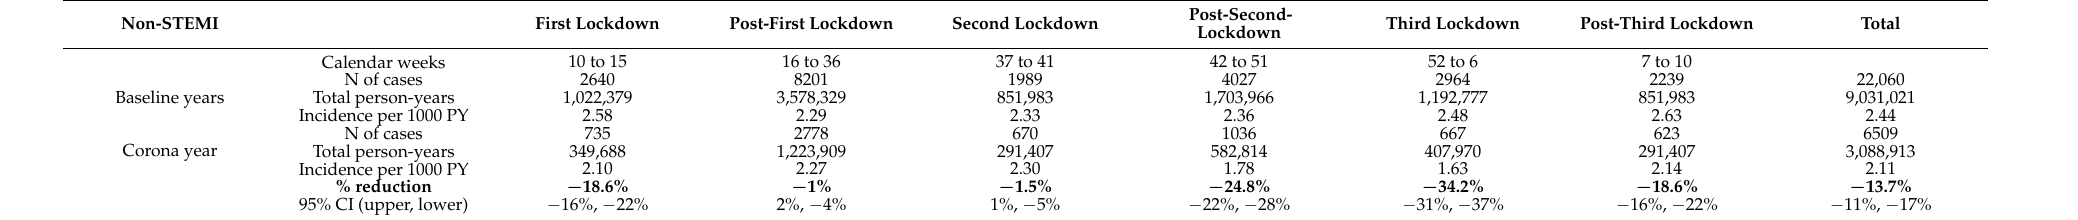
Table 3. Non-STEMI incidence by period during the Corona year and baseline years.